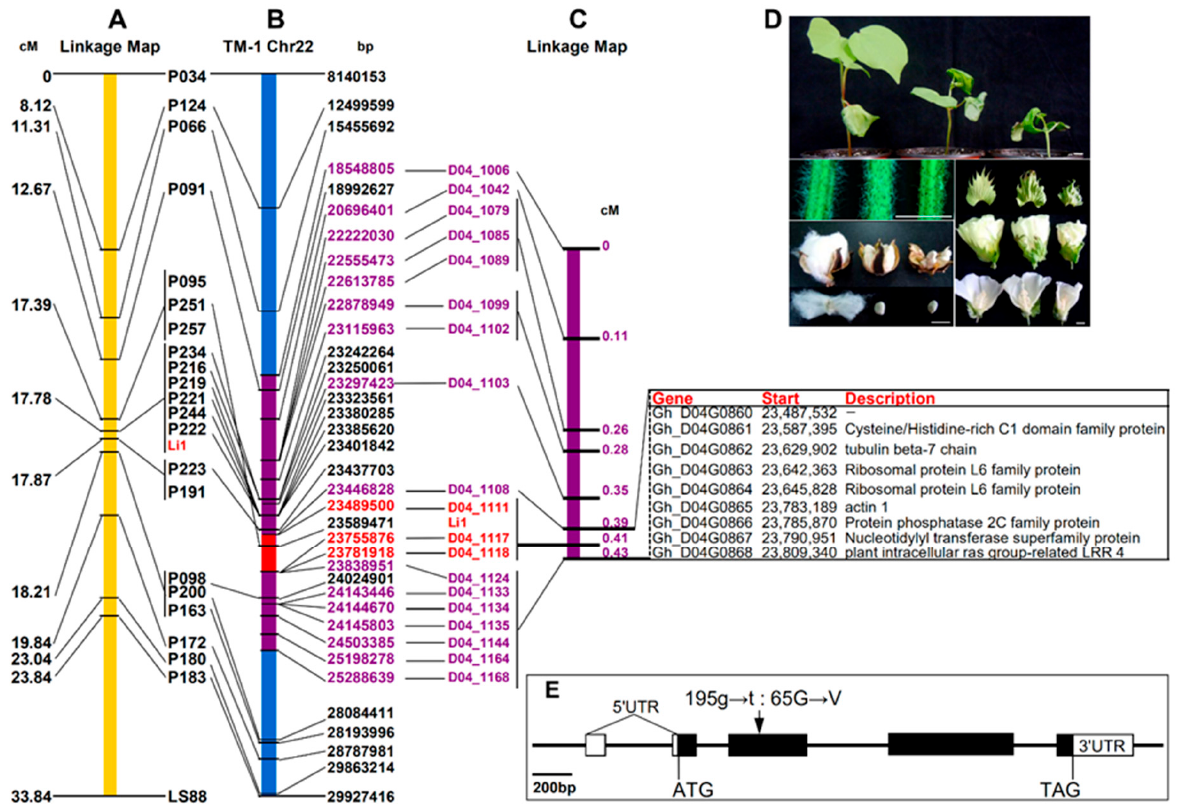
Figure 1. Genetic and physical maps of the Li 1 mutant and the candidate genes. ( A ), The fine map of the Li 1 gene from a previous paper (Jiang et al., 2015). ( B ), The physical map of the Li 1 gene, based on the published TM-1 reference genome (Zhang, et al., 2015). ( C ), The genetic map of Li 1 and the candidate genes constructed using all segregating data from current research. The lines connect the same DNA sequence in different maps. ( D ), The varied phenotypes from different genotypes of Li 1 . Scale Bars, 1 cm. ( E ), Gene structure of GhACT17D. Boxes represent exons; filled parts of boxes represent the coding region. The position of the point mutation in GhACT17DM is indicated by a black arrow.